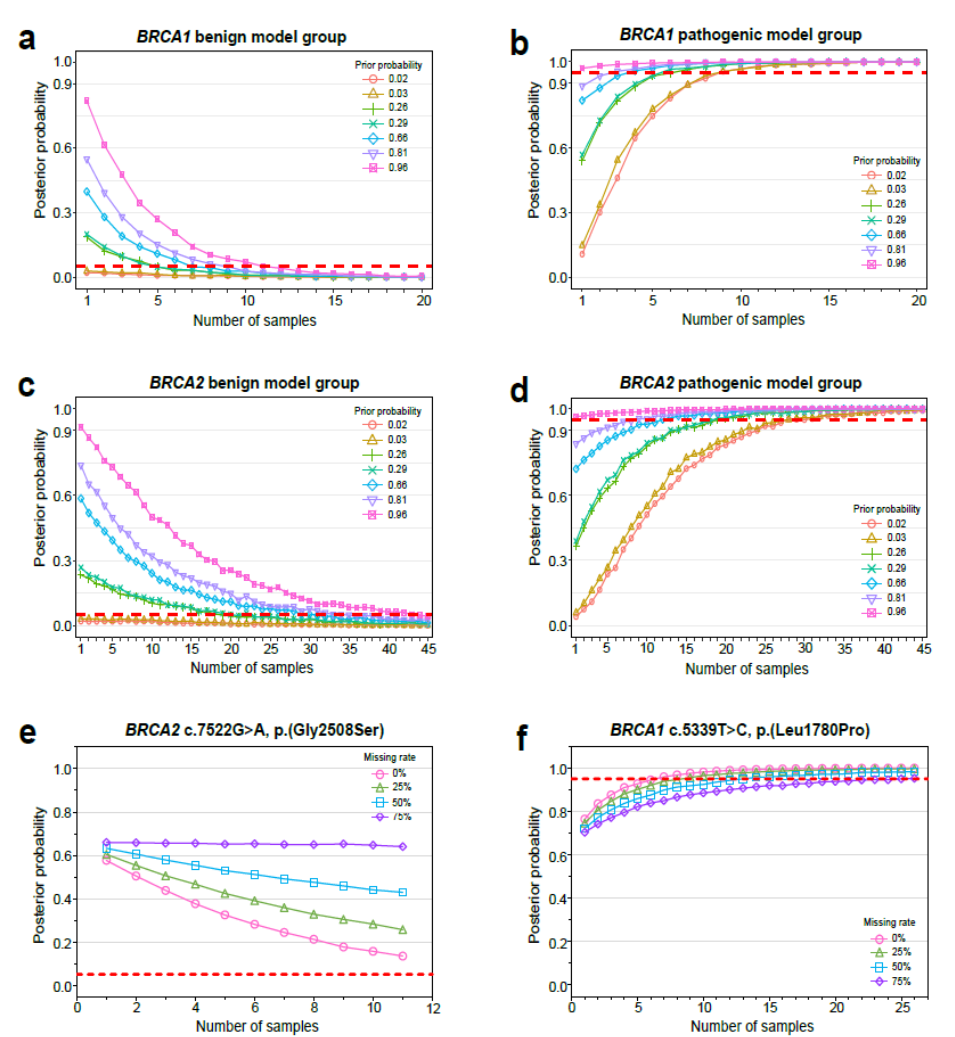
Figure 2. Simulation study estimating the sample numbers required to resolve unclassified status. We created two benign and pathogenic datasets, independent from the benign and pathogenic model groups. The benign set contained samples that had only (likely) benign variants according to the 2015 ACMG/AMP or IARC 1/2 variants, while the pathologic set contained samples that had (likely) pathogenic variants or IARC 4/5 variants. A simulation study on the posterior probability in ( a ) BRCA1 benign model group, ( b ) BRCA1 pathogenic model group, ( c ) BRCA2 benign model group, and ( d ) BRCA2 benign model group. Simulation study on the posterior probability depending on the presence of clinical information ( e ) at c.7522G>A, p.(Gly2508Ser) in BRCA2 and ( f ) c.5339T>C, p.(Leu1780Pro) in BRCA1 . The prior probability of these two variants was the same at